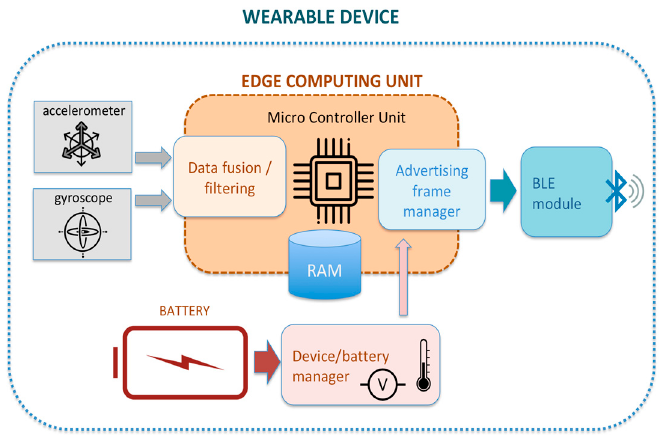
Figure 3. Wearable device components.